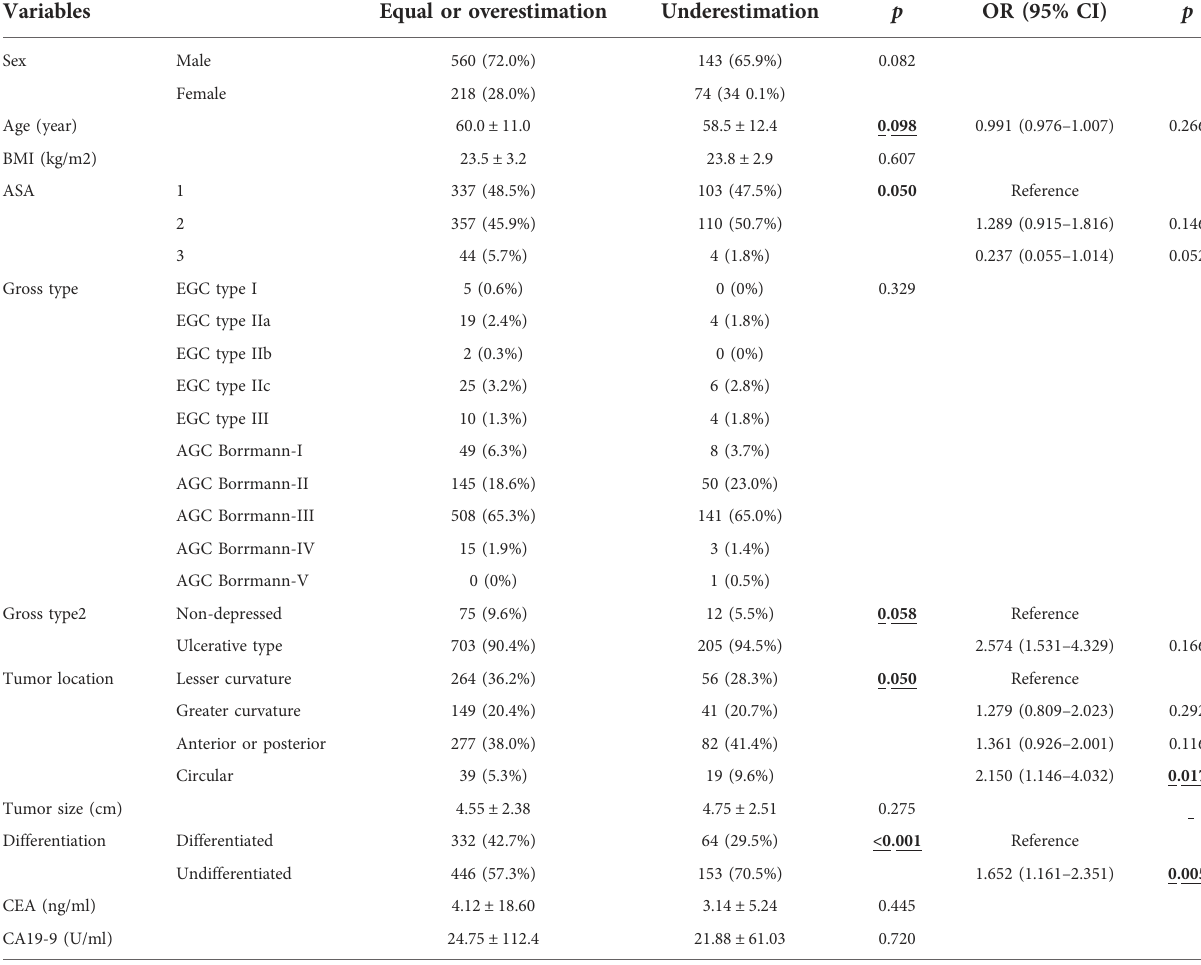
TABLE 6 Univariate and multivariate risk factor evaluation for underestimation for clinical stage according to 8th AJCC classi fi cation.